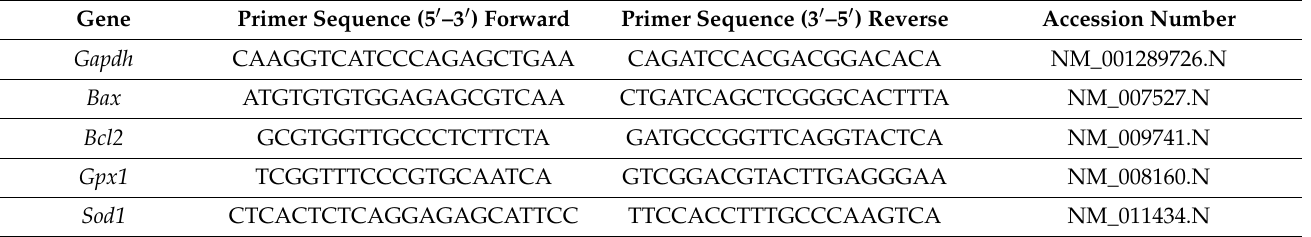
Table 1. Primer sequences of the target genes used for quantitative reverse transcription polymerase chain